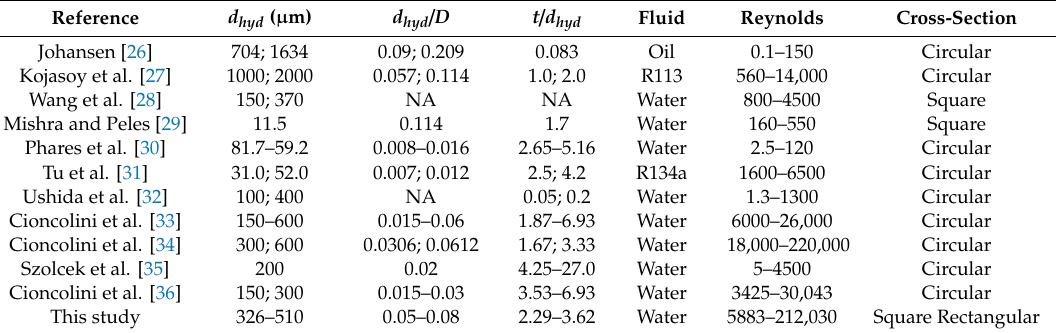
Table 1. Experimental data bank for micro-orifice liquid